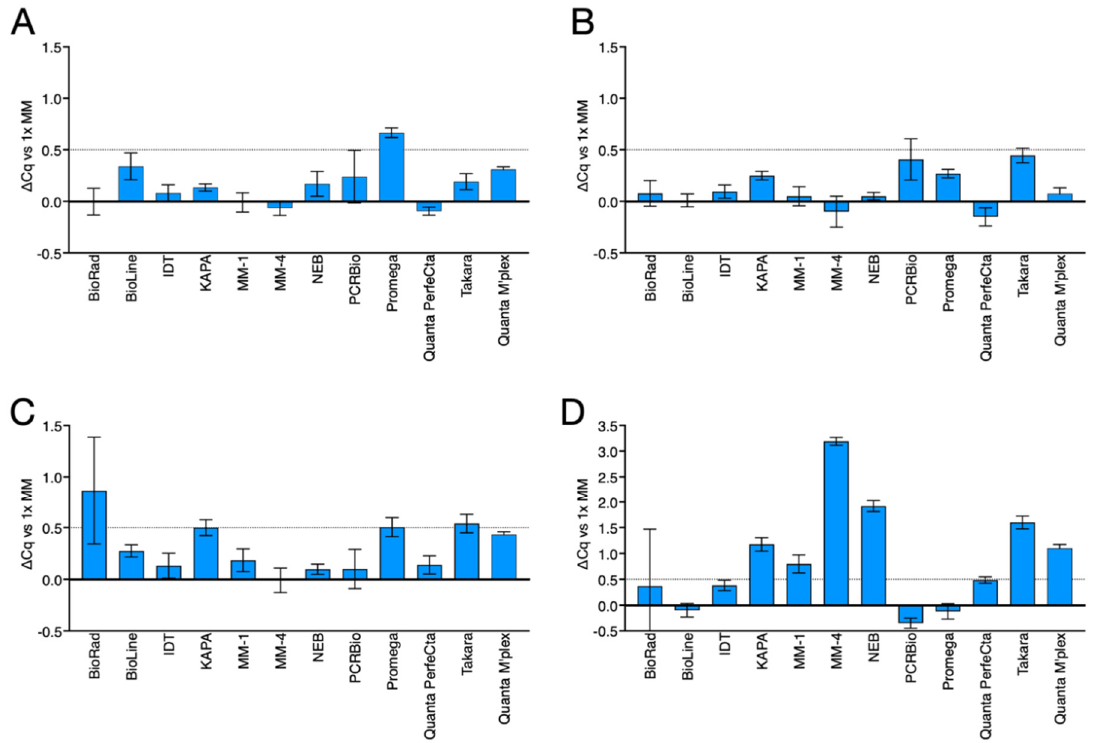
Figure 5. Comparison of amplifications carried out at reduced concentration of master mix. ( A ). ∆ Cq values for the twelve master mixes at 0.8× concentration. ( B ). ∆ Cq values for the twelve master mixes at 0.7× concentration. ( C ). ∆ Cq values for the twelve master mixes at 0.5× concentration. ( D ). ∆ Cq values for the twelve master mixes at 0.4× concentration. The dotted line indicates a ∆ Cq value of 0.5 relative to 1× concentration of master mix.